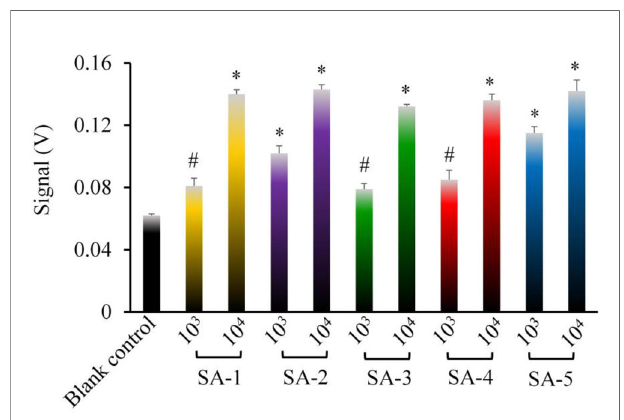
FIGURE 7 | The sensitivity of the biosensor for the detection of the fi ve clinically isolated S. aureus strains. The results showed that the sensitivity could reach 10 3 CFU/ml in the detection of some clinical S. aureus strains. * represented P < 0.05 and # represented P > 0.05 comparing with the blank control group (PBS). SA-1 to SA-5 represented fi ve S. aureus strains isolated from different patients. Error bars are based on standard deviations (n =